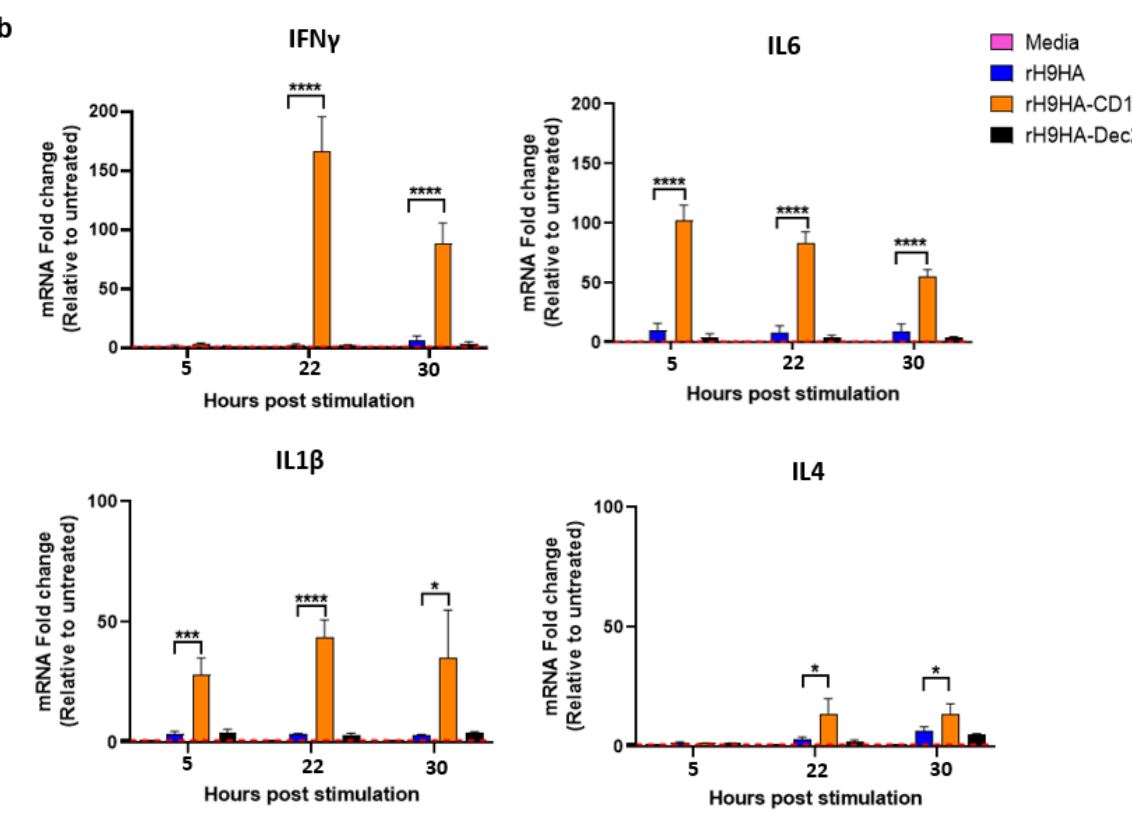
Figure 5. qRT-PCR analysis of IFN γ , IL6, IL1 β and IL4 production by splenocytes upon stimulation with scFv, rH9HA, and rH9HA-scFv. ( a ) Analysis of cytokine mRNA levels in splenocytes stimulated with Dec205 scFv and CD11c scFv. ( b ) Analysis of cytokine mRNA levels in splenocytes stimulated with rH9HA, rH9HA-Dec205 scFv, and rH9HA-CD11c scFv. Splenocytes were isolated from the spleen of 3 weeks old SPF chickens using Histopaque 1083 and stimulated with 10 μ g of scFv/rH9HA/rH9HA-scFv for 5, 22, and 30 h in vitro. Stimulated splenocytes were harvested for RNA extraction and the expression levels of the respective cytokines were measured by qRT-PCR. Data were calculated using 2- ∆∆ CT approach (n-fold change compared to the media only control group) and reported as values normalised to the expression level of a housekeeping gene RPLPO1. Data are presented as mean + SD and analysed by one-way ANOVA followed by Tukey’s multiple comparison test. **** p < 0.0001, *** p < 0.001, ** p < 0.01, * p < 0.05. The data represent three independent experiments.